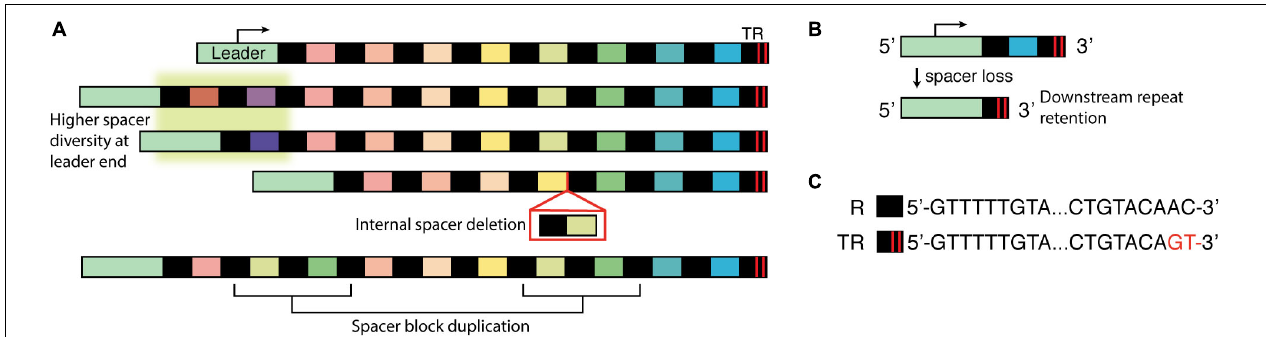
FIGURE 1 | Cartoon diagram of CRISPR array organization and key processes. (A) CRISPR arrays from related strains or isolates were compared; differences in spacer composition illustrated three key characteristics: highest spacer diversity is found at the leader-adjacent end of the array (highlighted in green ), missing spacers in the array suggest spacer deletion events, and repeated blocks or repeated individual spacers suggests duplication events. (B) Sequencing showed that the downstream repeat is maintained after an upstream spacer-repeat unit deletion. (C) Example internal repeat (R) and terminal repeat (TR) for a type II-A CRISPR array from Streptococcus thermophilus . The 3 (cid:48) end (leader distal) has two nucleotide substitutions, which disrupt dyad symmetry at the ends.